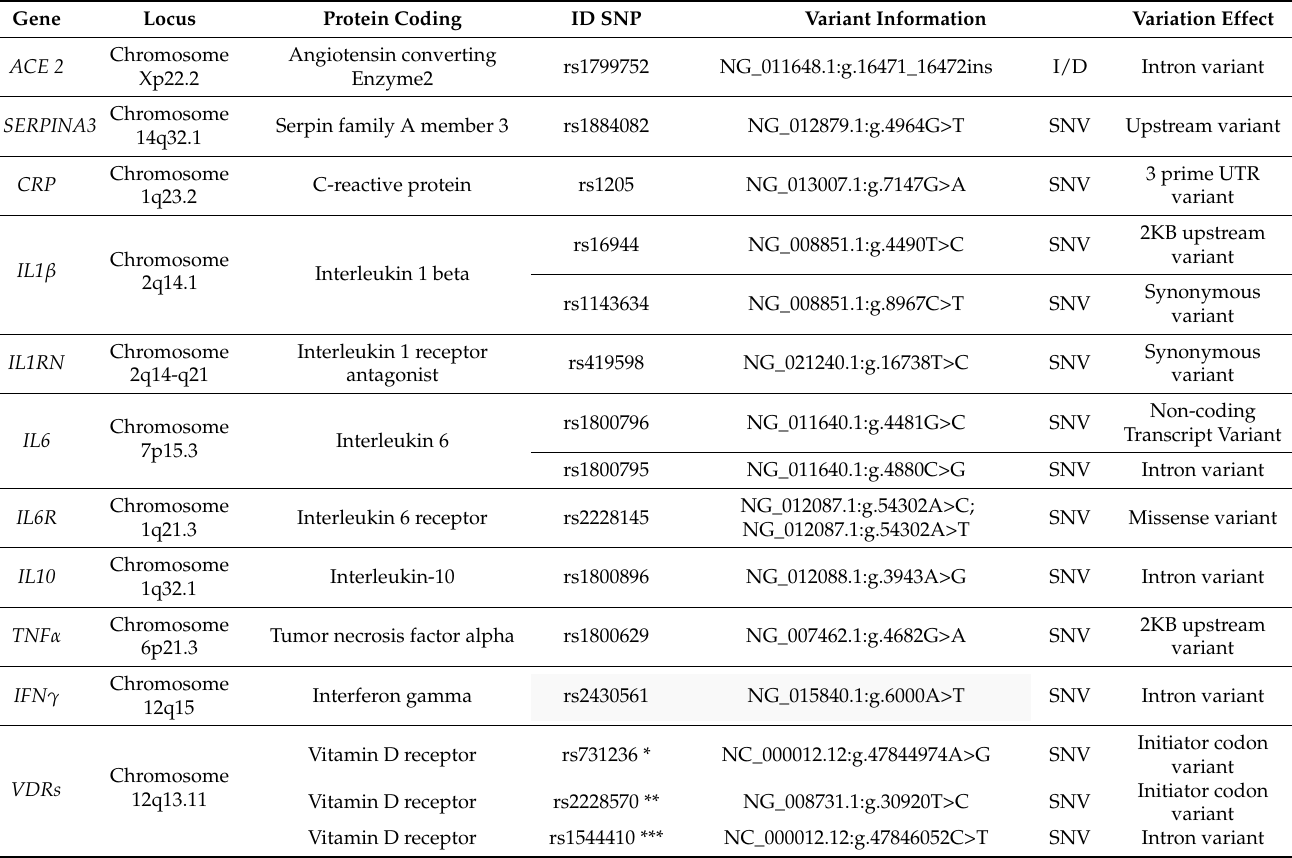
Table 1. List of analyzed